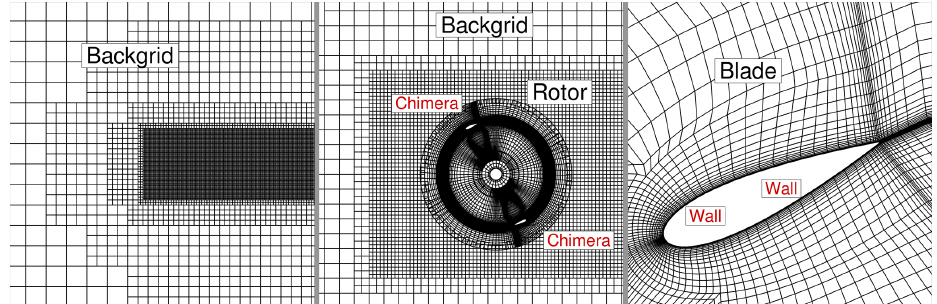
Figure 3. Computational grid of the H-VAWT for the uniform-inflow study. Boundary conditions are shown in red-coloured text. (Not to scale, and every fourth cell of the mesh is shown).